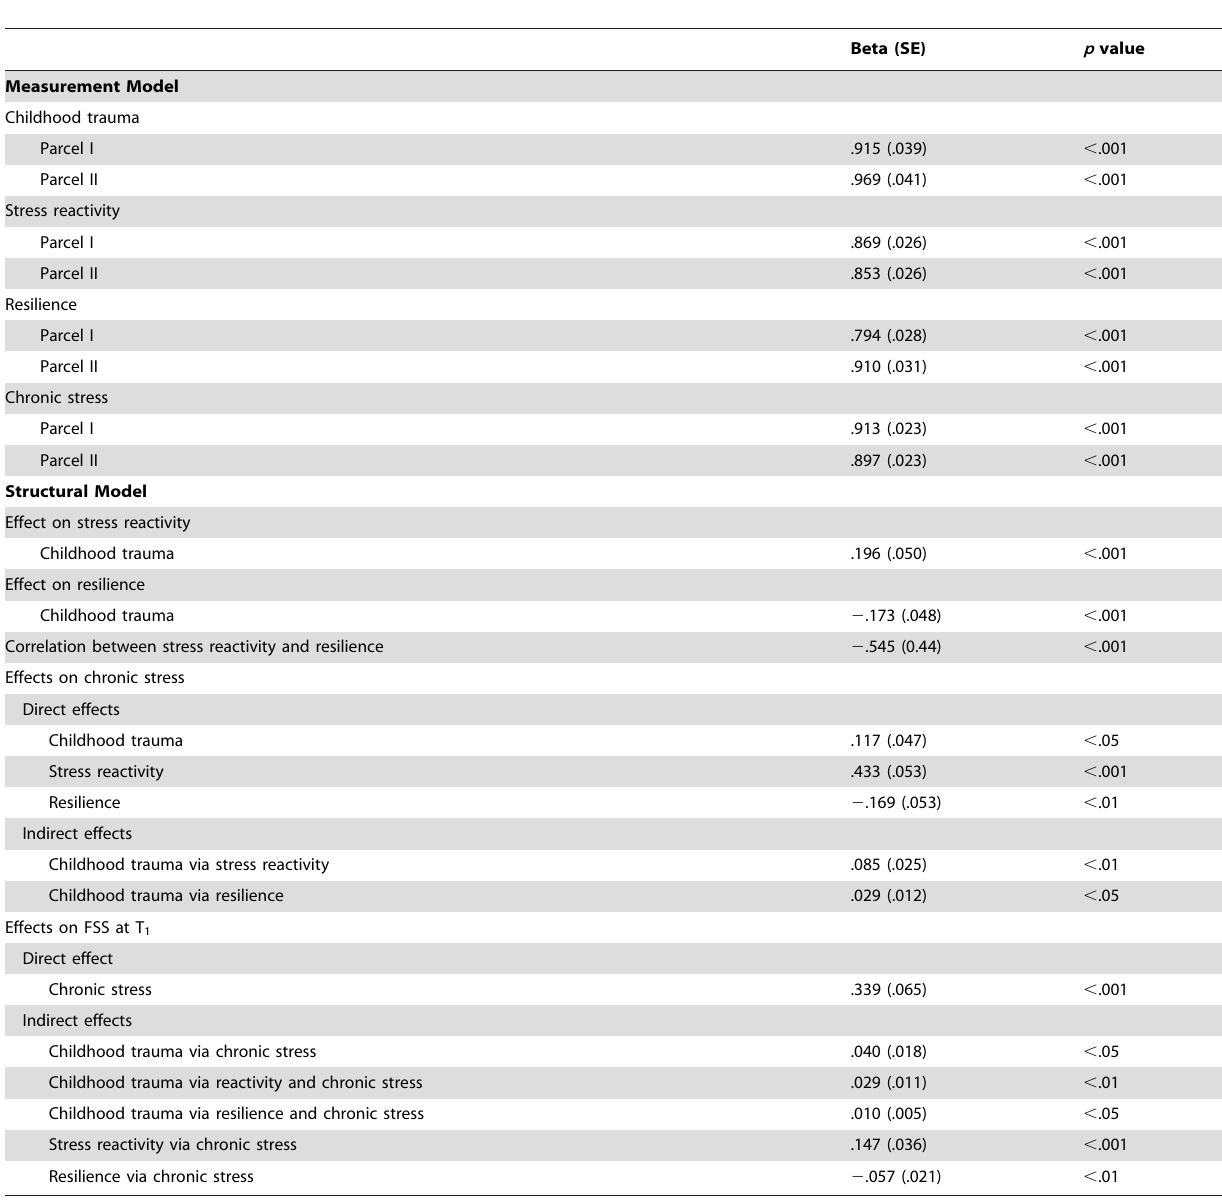
Table 2. Longitudinal model direct and indirect effects (standardized coefficients) of variables on chronic stress and FSS (T 1